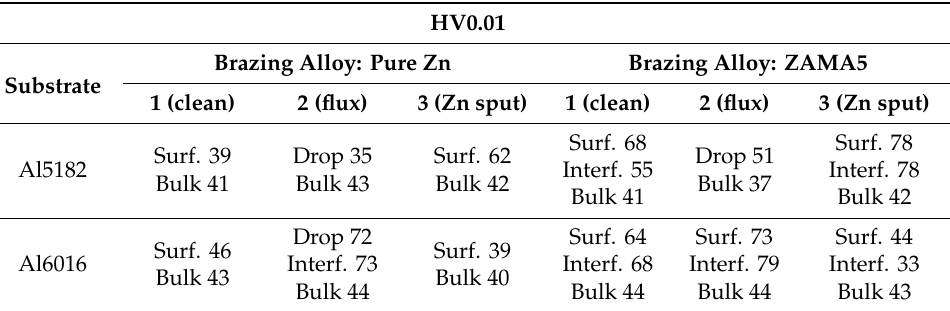
Table 2. Microhardness